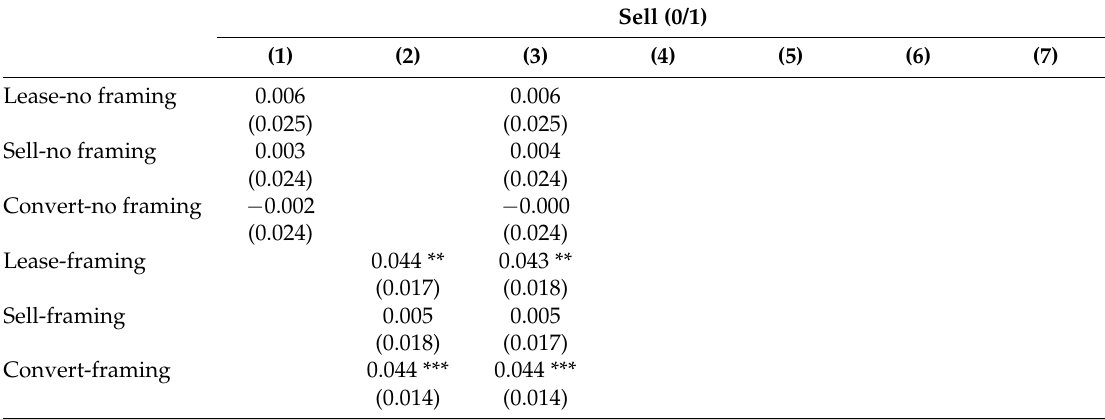
Table 10. Predictors of pasture conversion by land